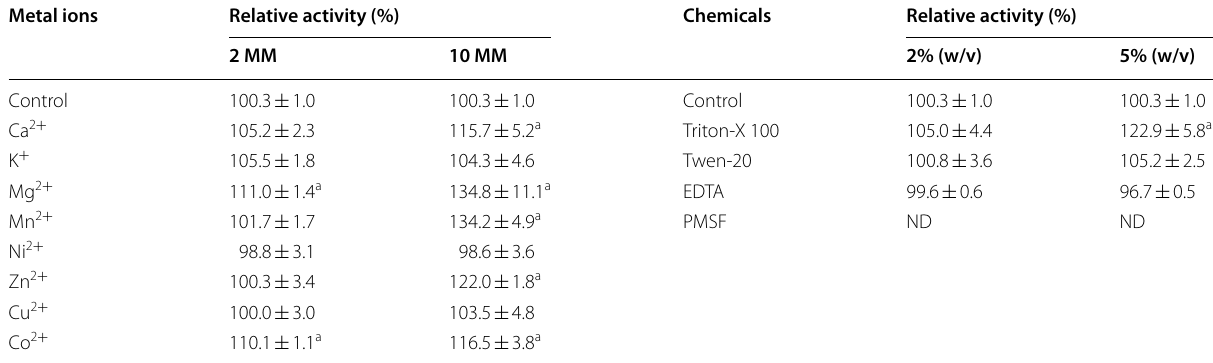
ND not detected a Significant difference ( p < 0.05)